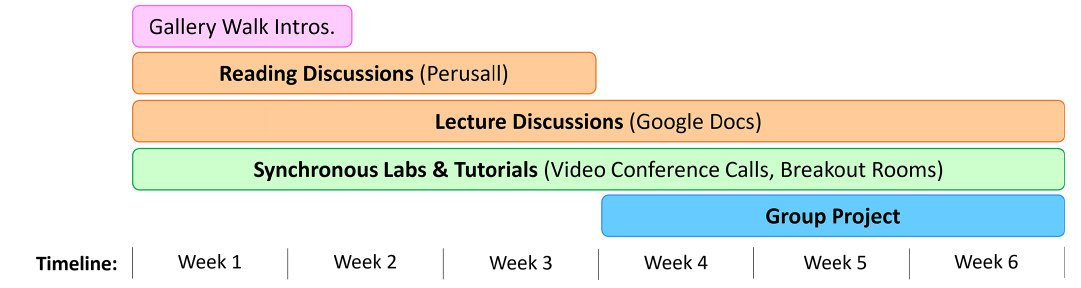
Figure 9. Summary timeline of elements for building a class community embedded within GEOE/L 221 in fall